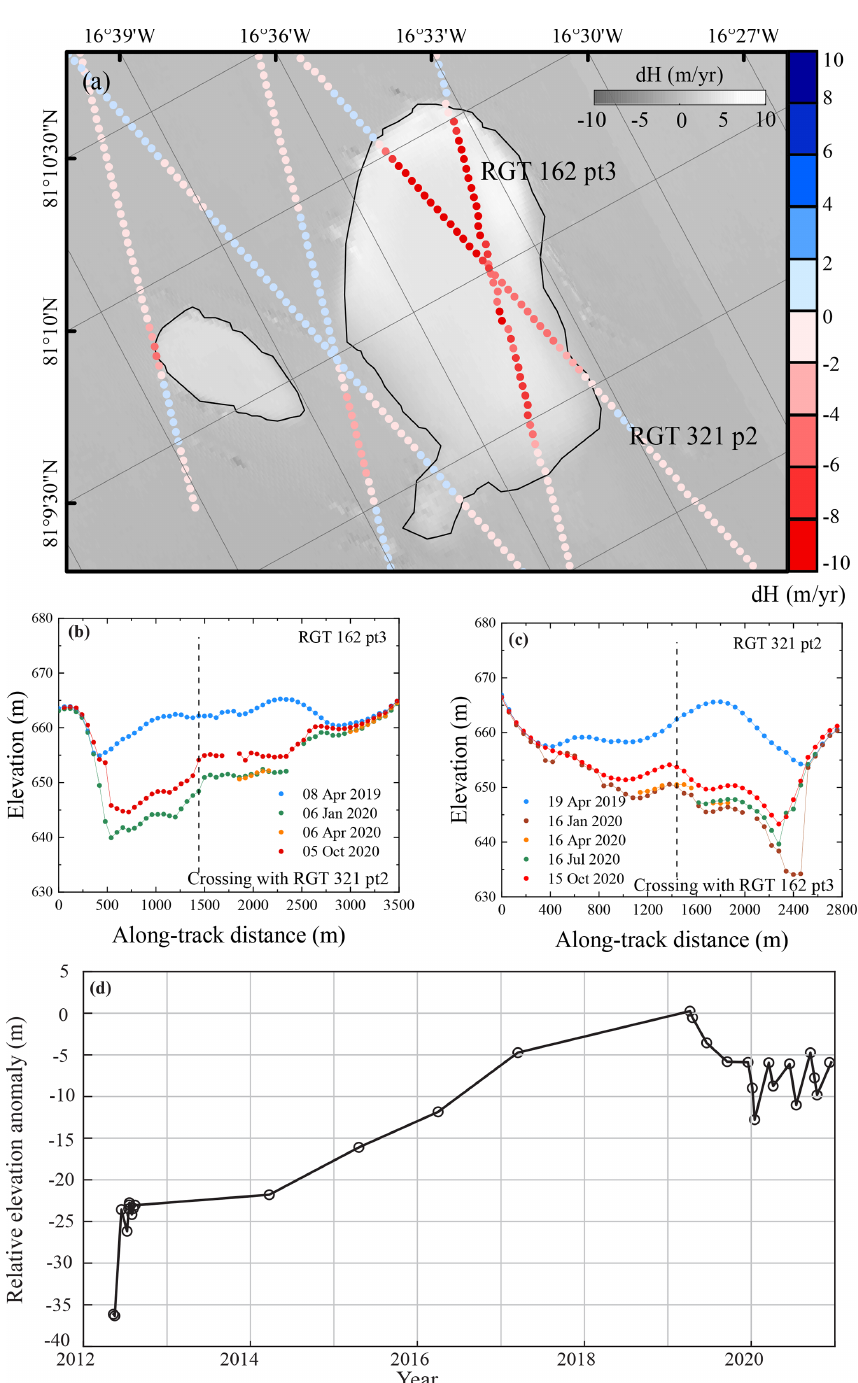
Figure 1. Active subglacial lake detection method, using subglacial lake ICE_CAPS_NE01 as an example. (a) The elevation-change rate was derived from ICESat-2 and overlaid on the elevation-difference maps between the two ArcticDEMs (23 September 2016–21 June 2016). The black polygons show the inferred lake boundaries derived from the ArcticDEM. The red and blue spots represent the elevation-change rate derived from the linear fit of ICESat-2, while the grayscale color bar represents the elevation-change rate derived from the ArcticDEM. Elevation-anomaly profiles across the subglacial lake are given for (b) RGT 162 pair track (pt)3 and (c) RGT 321 pt2. The colors of the points correspond to the ICESat-2 observation times, and the vertical dashed lines show the location of the cross point. (d) Time series of relative elevation anomaly based on the combined ArcticDEM and ICESat-2 tracks. Note the ∼ 30m of ice uplift over 6 years that is interpreted to be subglacial lake filling, followed by 10m of subsidence over 1 year interpreted as slow subglacial lake drainage.